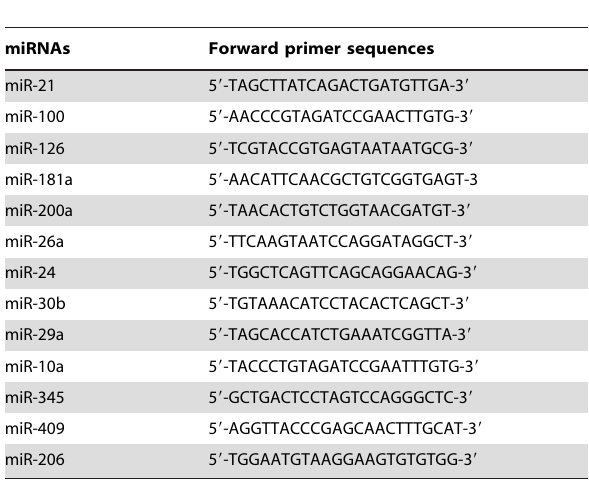
Table 2. Forward Primers Used for miRNA Expression Analysis.